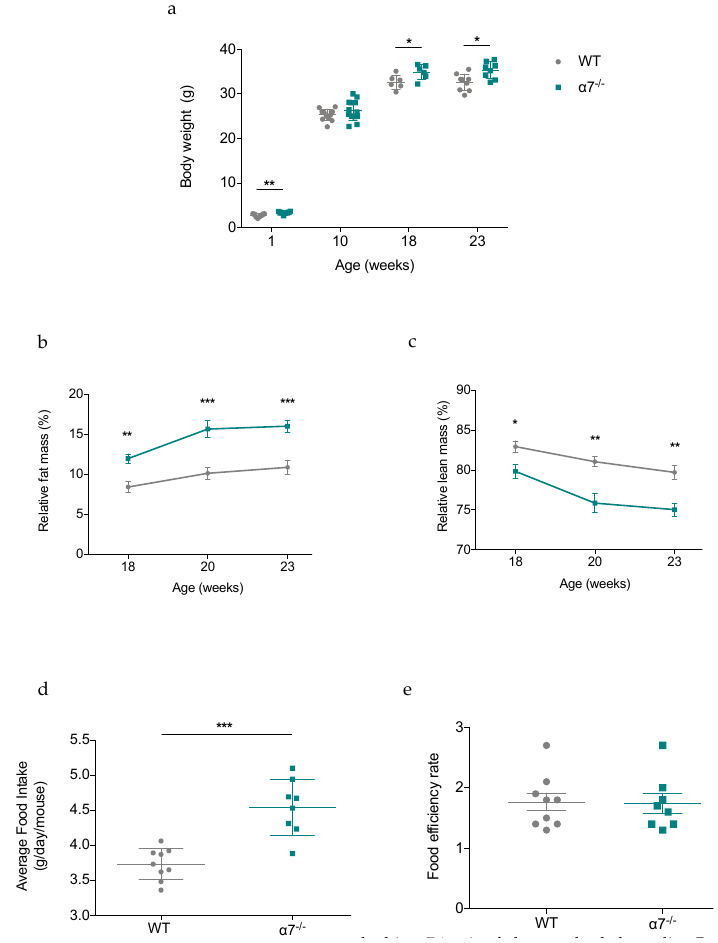
Figure 6. Body weight and food intake are disturbed in α 7 − / − mice fed a standard chow diet. Body weight was measured in WT control and α 7 − / − mice at 1, 10, 18, and 23 weeks of age ( a ). The percentage of fat ( b ) or lean ( c ) mass relative to body weight was assessed by EchoMRI in 18-, 20- and 23-week-old in WT control and α 7 − / − mice. Cumulative average daily food intake between 14 and 24 weeks of age in α 7 − / − mice compared with age-matched WT controls ( d ). Evaluation of food efficiency rate was calculated as weight gain (g/day) over food intake (g/day) from 14 to 24 weeks old in α 7 − / − and WT control mice ( e ). Each dot represents a mouse (grey dots for WT mice and green squares for α 7 − / − mice). All data are presented as mean ± SEM. Symbols *, ** and *** indicate a significant difference compared to control WT using unpaired Mann-whitney two-tailed test ( a–e , n = 4–13/group, * p < 0.05; ** p < 0.01 and *** p < 0.001).